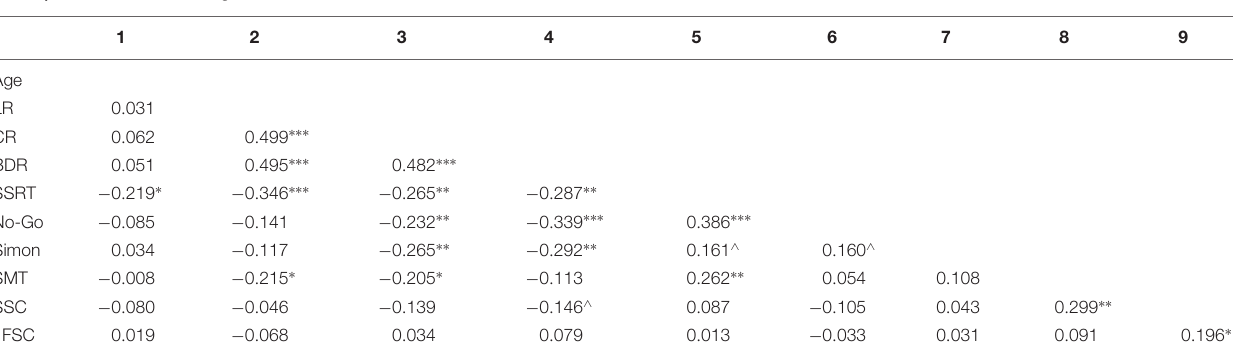
TABLE 5 | Intercorrelations amongst the variables.